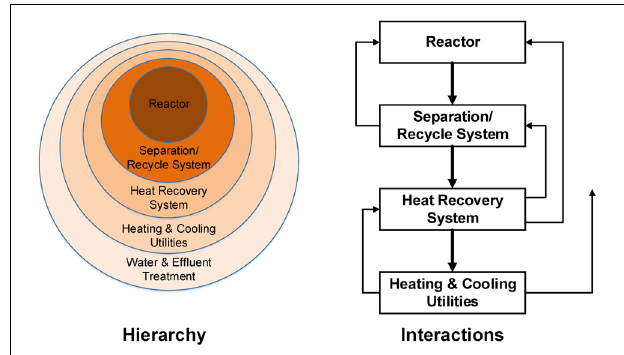
FIGURE 1 | Hierarchy and interactions of industrial process-related systems (adapted from Gundersen, 2002).